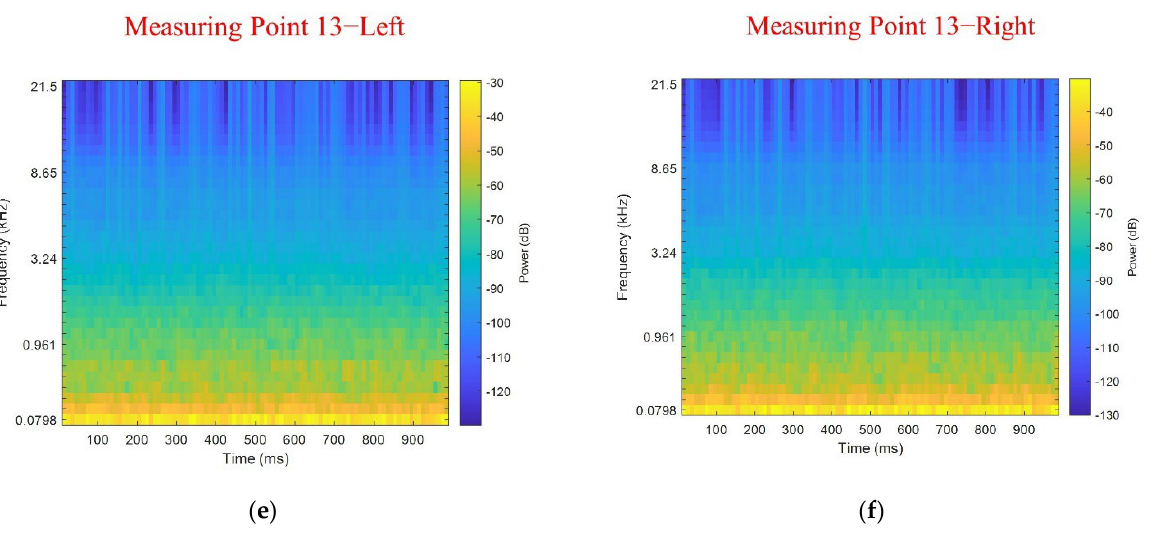
Figure 5. Mel spectrogram: ( a ) Measuring point 1 Left; ( b ) Measuring point 1 Right; ( c ) Measuring point 7 Left; ( d ) Measuring point 7 Right; ( e ) Measuring point 13 Left; ( f ) Measuring point 13 Right.